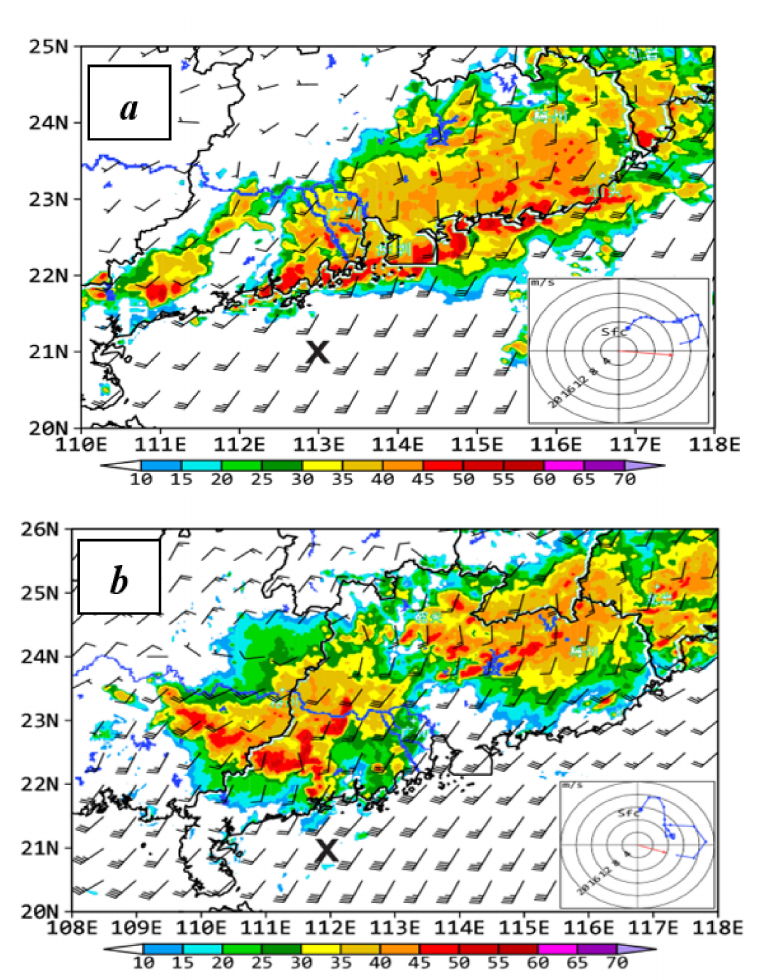
Figure 15. As in Figure 13, but the TL/AS type of MCSs: ( a ) horizontal winds (HW) at 925 hPa at 0800 BST and the composite radar reflectivity (RR) at z =1 km at 0450 BST 22 May 2013; ( b ) horizontal winds at 925 hPa at 0800 BST and RR at z = 1 km at 0900 BST 16 May